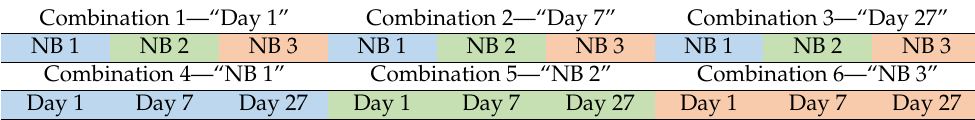
Table 4. Six combinations of images were arranged to analyze the hydration behavior of differently cured samples. ently cured samples.